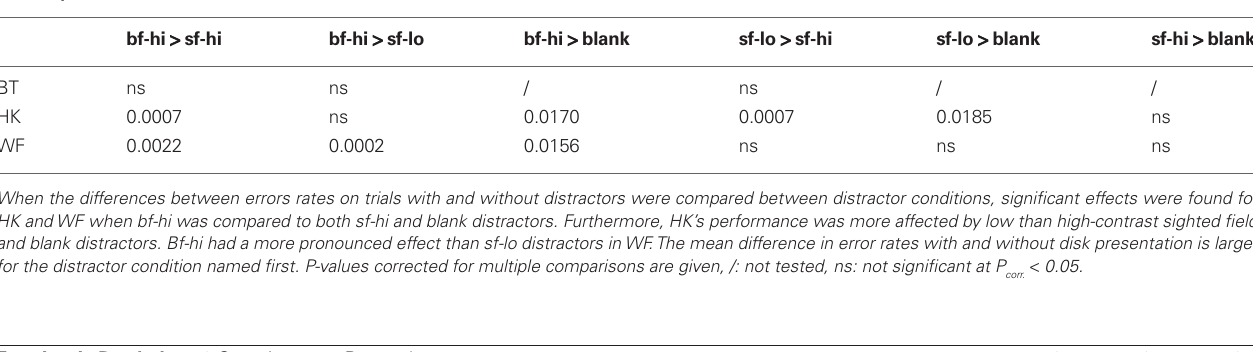
Table 1 | Trial type-dependent effects of distractor